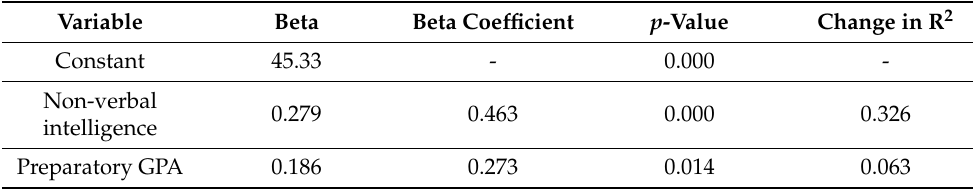
Table 3. Multiple regression analysis for GPA in